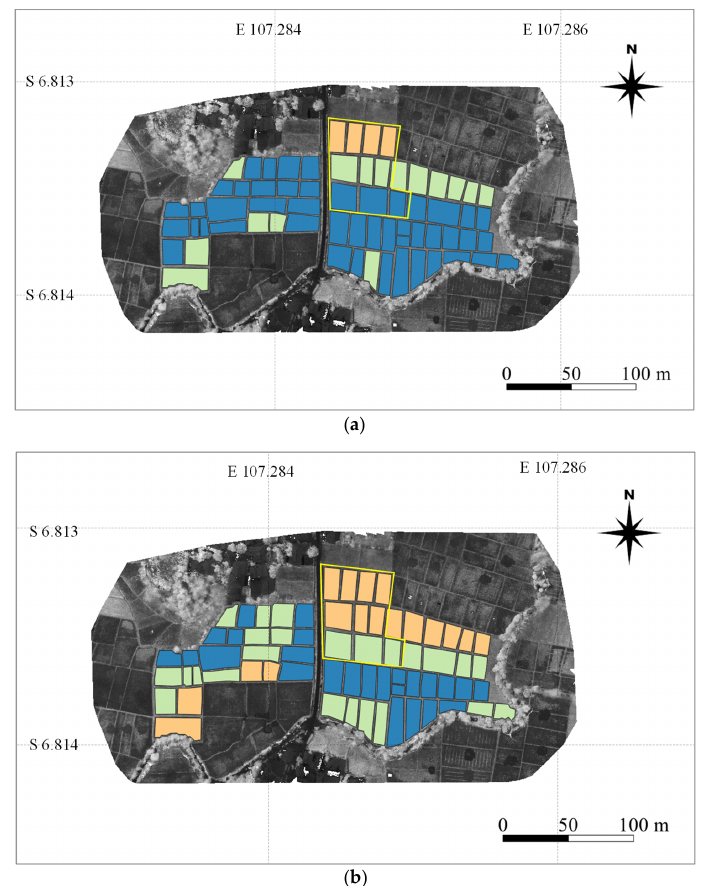
Figure 8. Classification results of the two methods in Karangwangi: ( a ) an assessment result by method1; ( b ) an assessment result by method2. Assessment result by a PO is shown in Figure 3b. Legends are same as Figure 7.